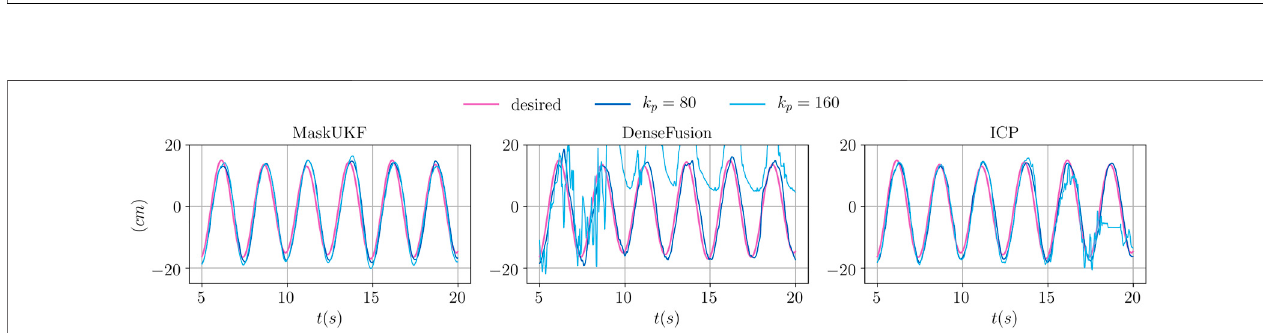
FIGURE 8 | Evolution of the y coordinate of the end-effector for several algorithms and different proportional gains.